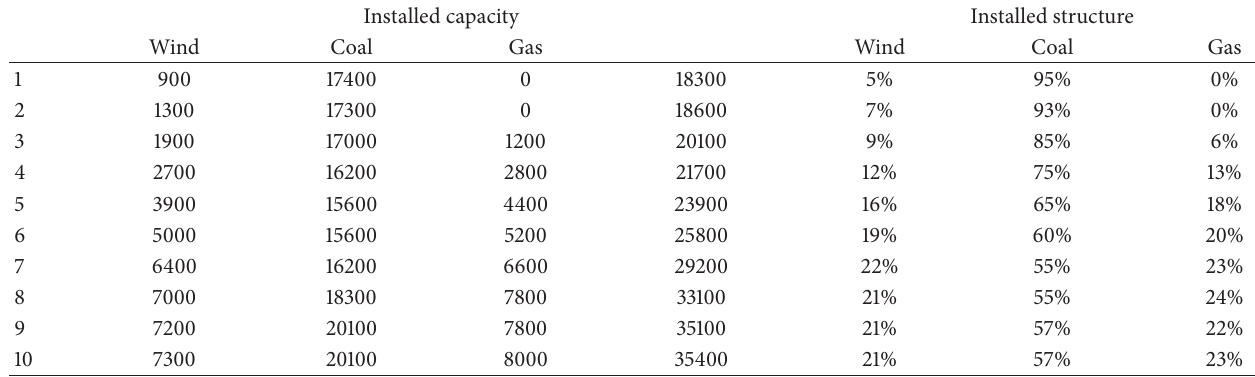
Table 15: System installed capacity and structure distribution in Case 4.